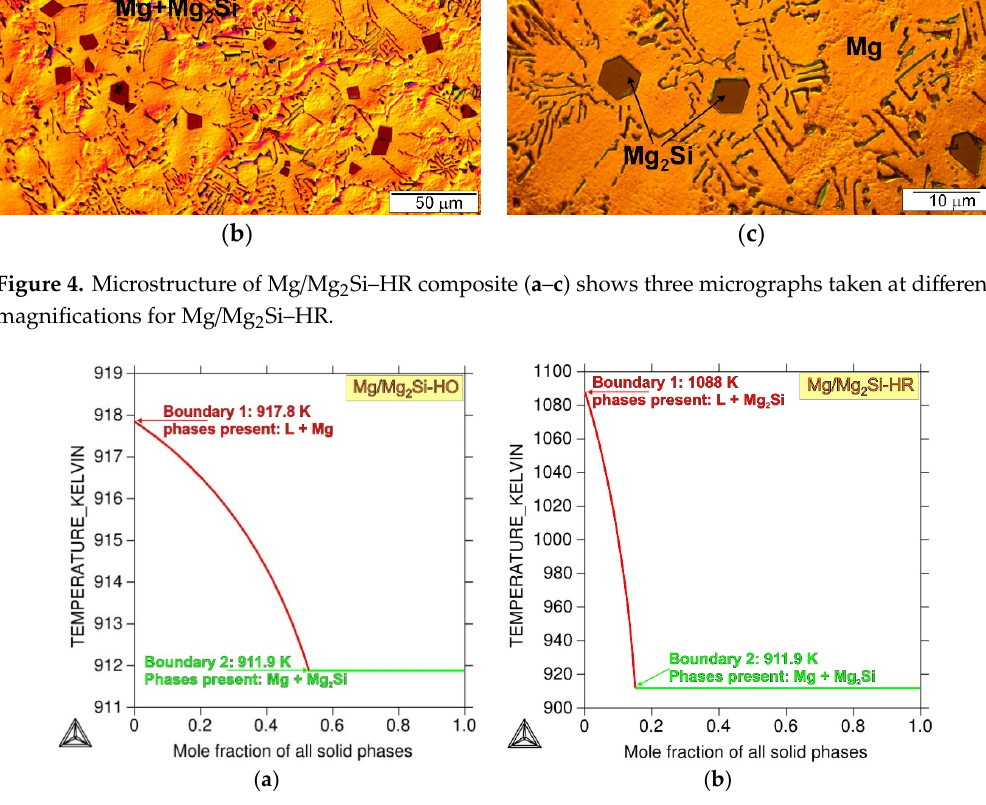
Figure 5. Sheil solidification simulation for Mg/Mg 2 Si–HO ( a ) and Mg/Mg 2 Si–HR ( b ) composites (calculated in Thermo-Calc Software [48]).